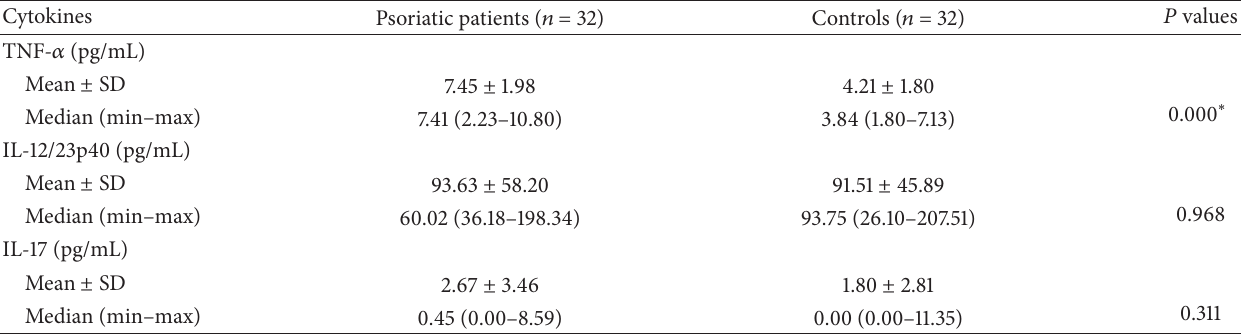
Table 2: Serum levels of TNF- 𝛼 , IL-12/23p40, and IL-17 in psoriatic patients and controls.